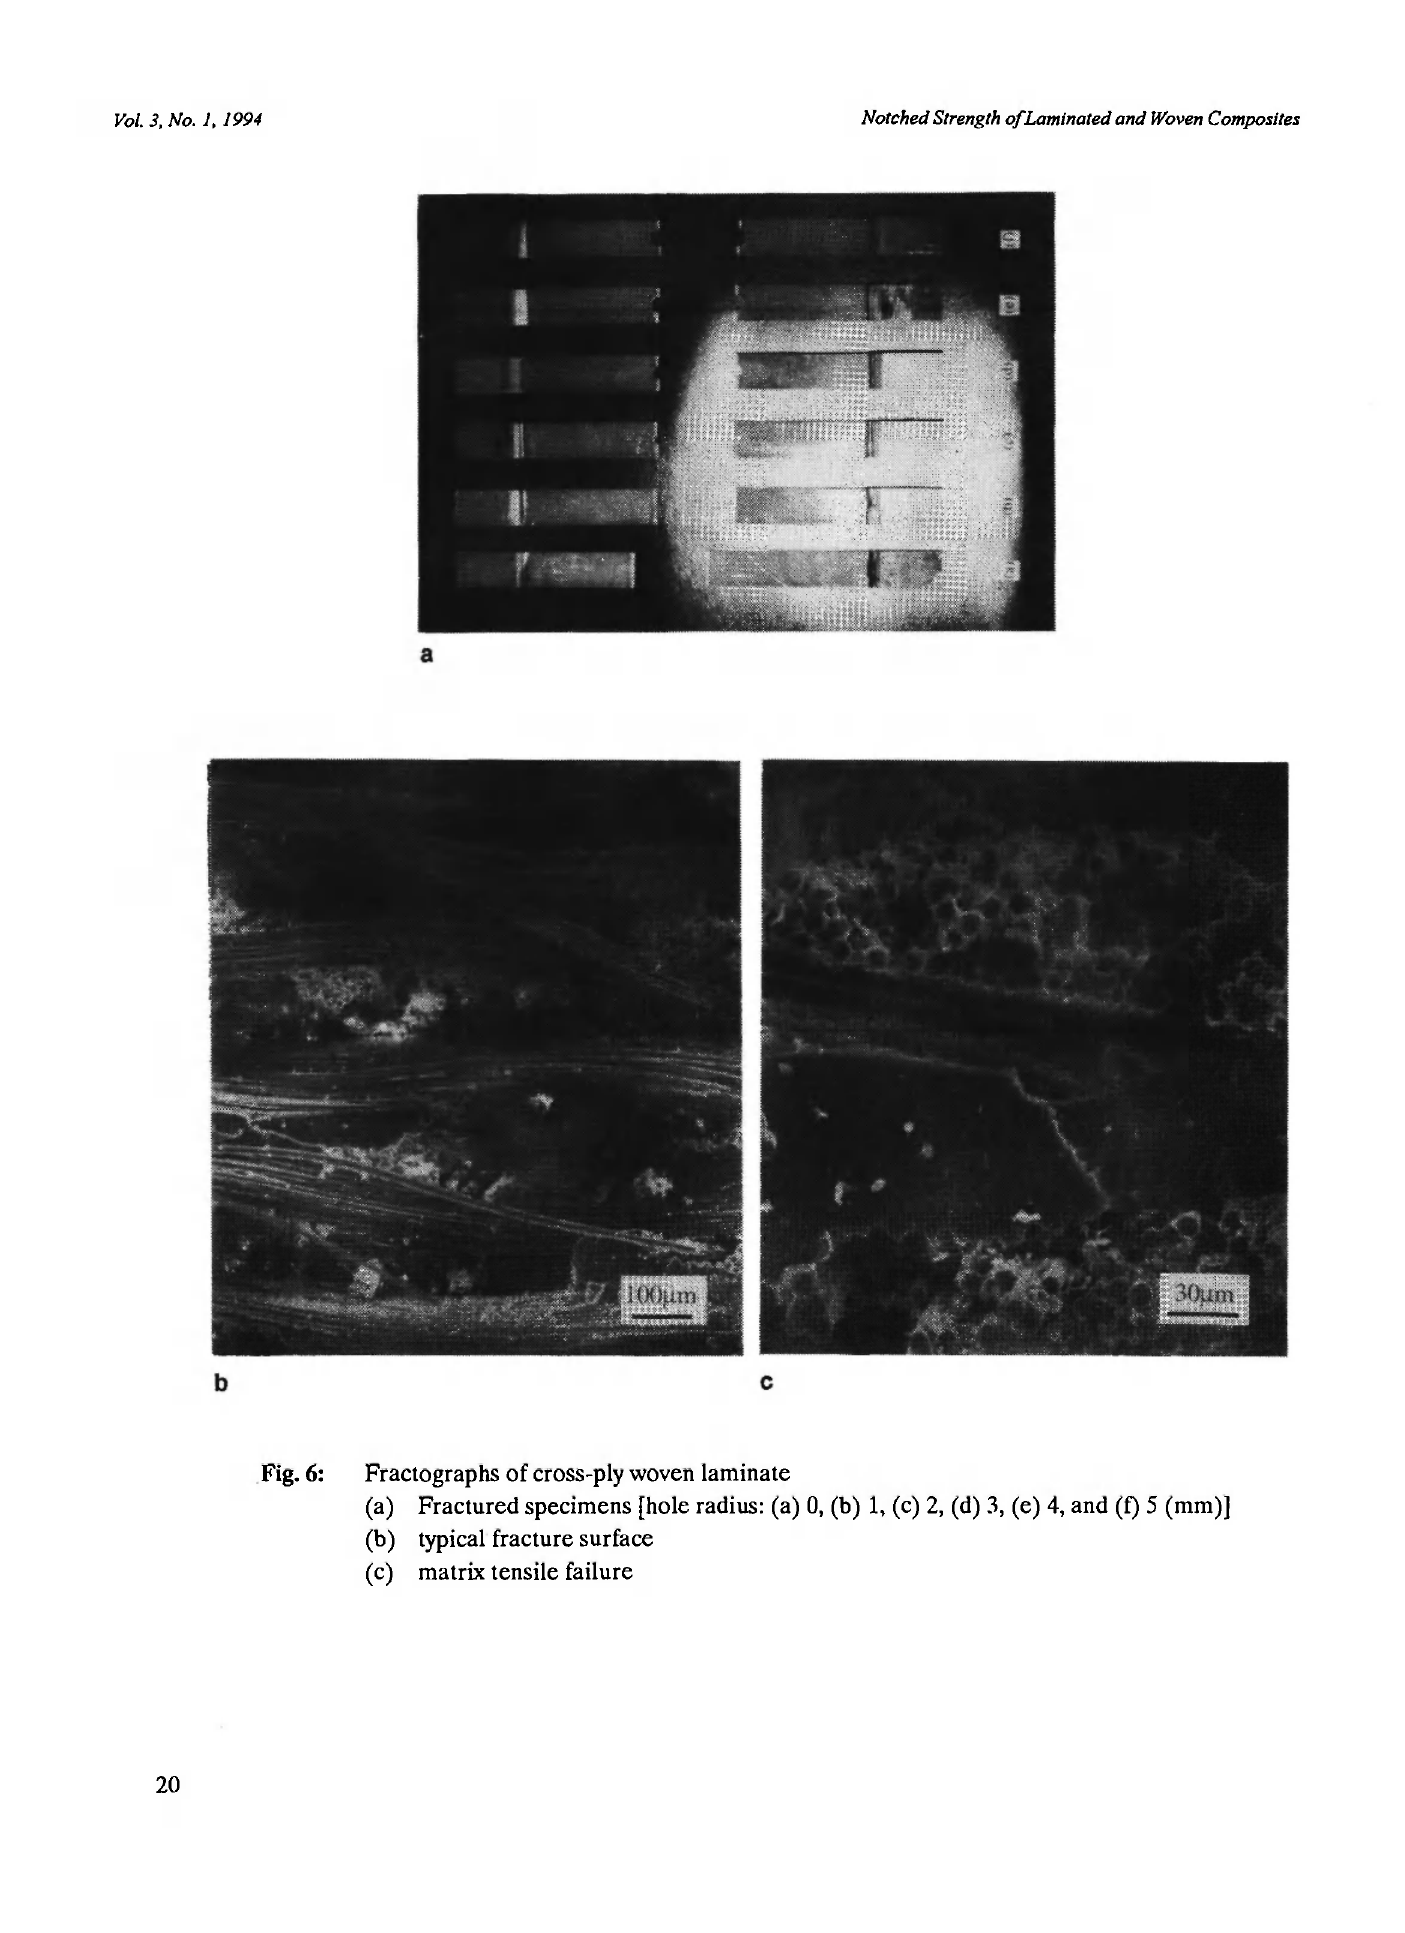
Fig. 6: Fractographs of cross-ply woven laminate (a) Fractured specimens [hole radius: (a) 0, (b) 1, (c) 2, (d) 3, (e) 4, and (f) 5 (mm)] (b) typical fracture surface matrix tensile